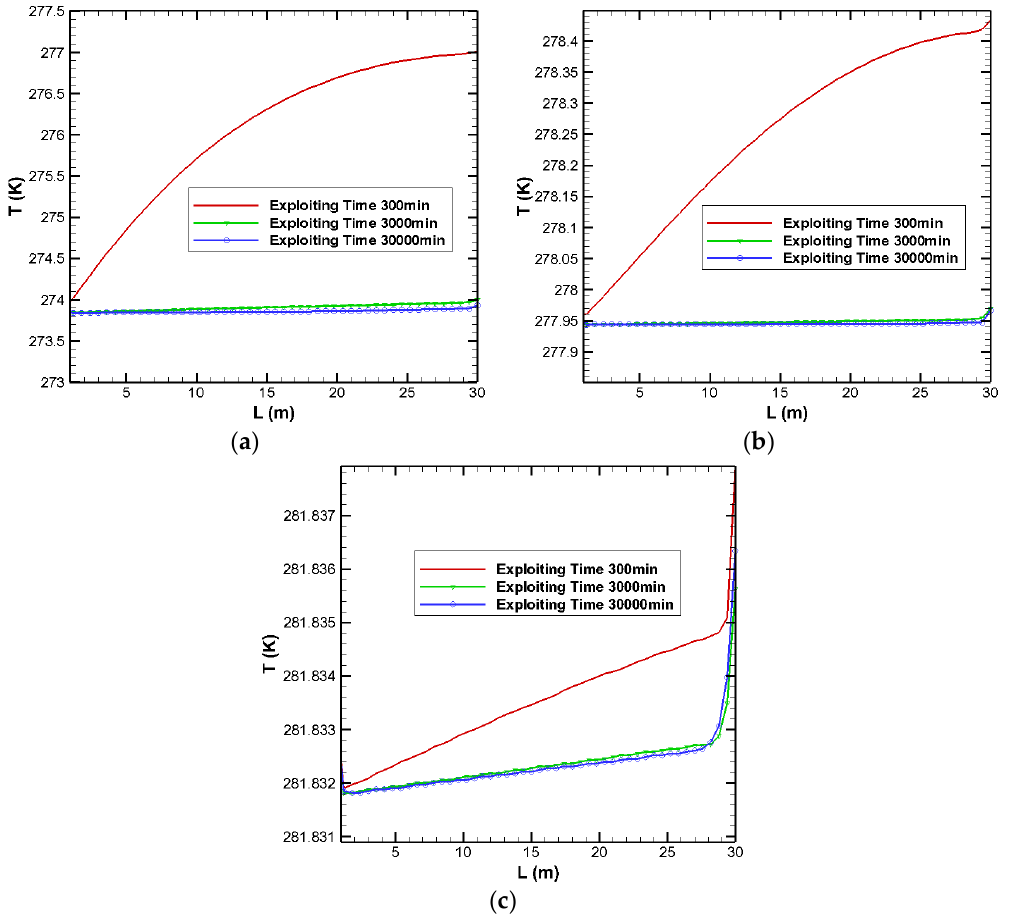
Figure 6. Comparison of temperature distributions in reservoir under initial temperature of 284 K and different well pressures ( a ) 3 MPa; ( b ) 5 MPa; ( c ) 8 MPa at different exploiting time (300 min, 3000 min, and 30,000 min).